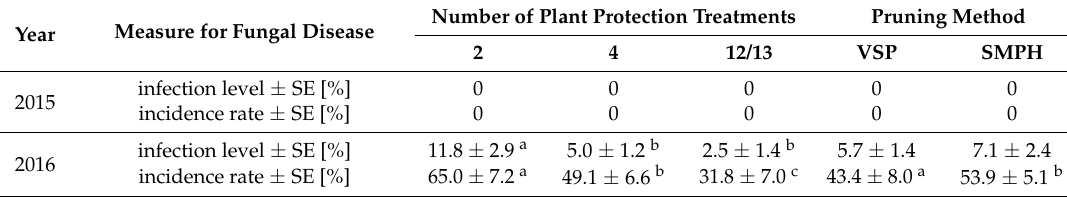
Table 1. Infection level and incidence rate of Plasmopara viticola compared between grapevine leaves under three plant protection intensities and between the pruning methods VSP (vertical shoot positioning) and SMPH (semi-minimal pruned hedge). Significant differences between groups are indicated by different